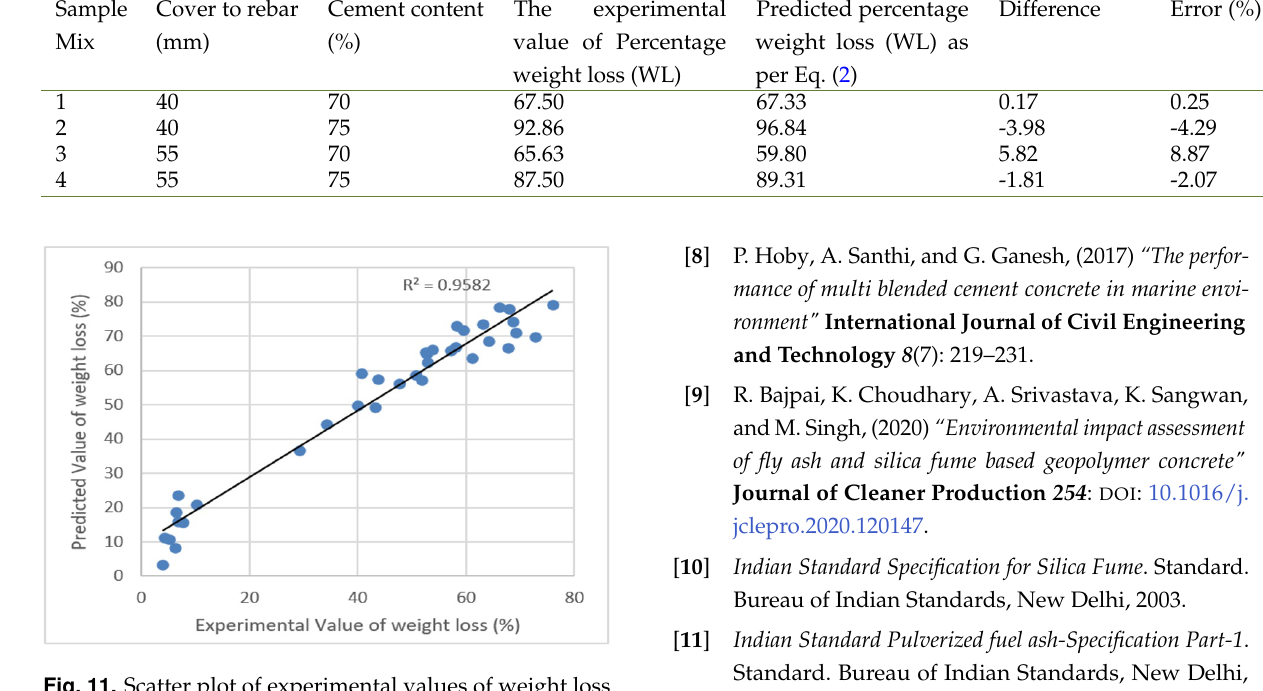
Fig. 11. Scatter plot of experimental values of weight loss in % against predicted